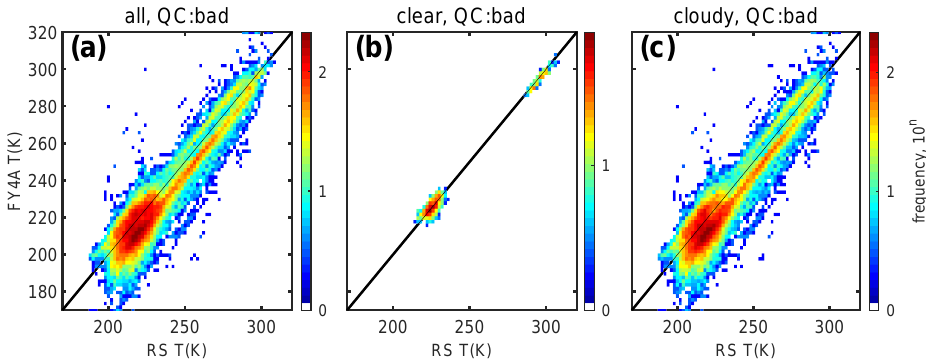
Figure 6. This figure shows the cases with QC flags of “bad” or “very bad”. The color means the frequency of the observation, 10 n , n is the value in the color bar. All the observations are shown in this figure except in the unreasonable cases in physics. ( a ): both clear sky and cloudy sky cases are included, with bias of − 3.5 K, RMS of 10.0 K, and PCC of 0.9174; ( b ): cases under clear sky only, with bias of − 0.9 K, RMS of 4.0 K, and PCC of 0.9954; ( c ): cases under cloudy sky only, with bias of − 3.8 K, RMS of 10.4 K, and PCC of 0.9121. All of the correlation coefficients are at 95% confidence level. The black line is the identity line.